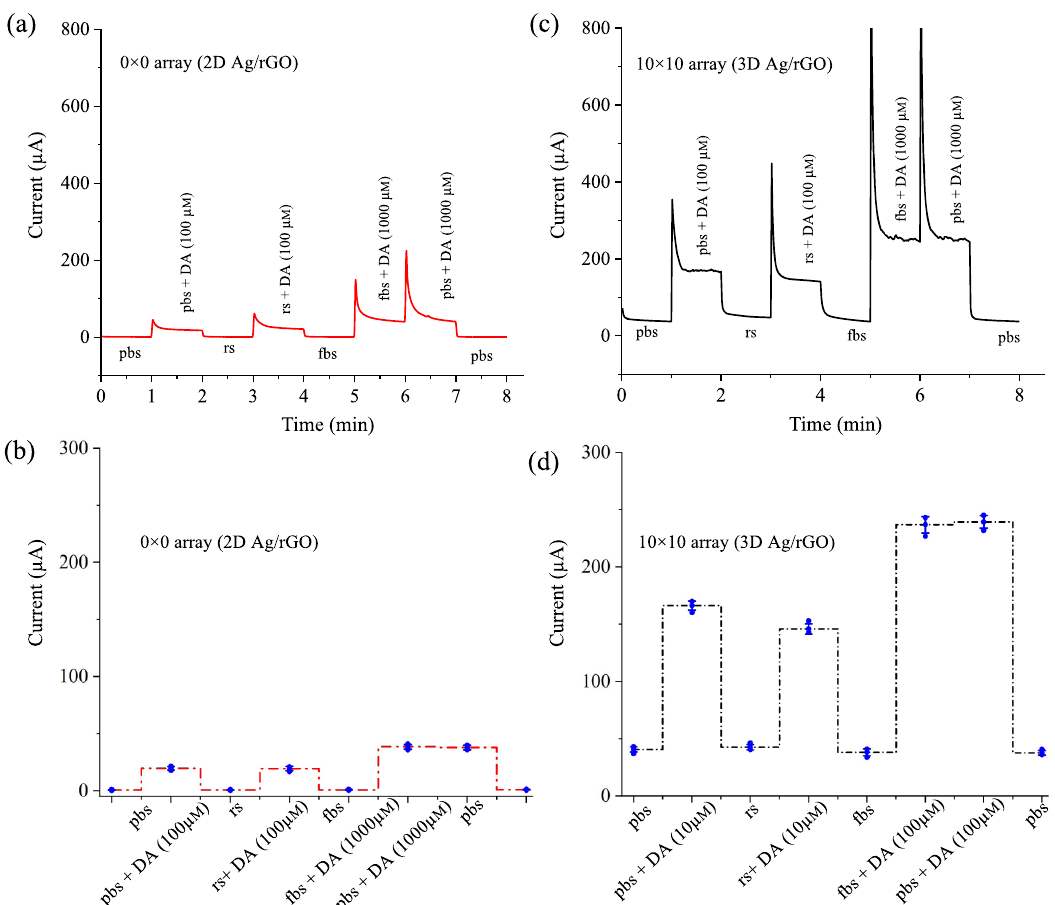
Fig. 5 In vitro dopamine sensing. Use of chronoamperometric method to detect dopamine for ( a ) 2D Ag/rGO (0 × 0 array) and ( c ) 3D Ag/rGO (10 × 10 array) sensors in the presence of pbs, fetal bovine serum (fbs), and rabbit serum (rs) with and without the addition of different concentration of dopamine (10, 100, and 1000 μ M ). Both rs and fbs are diluted 15 times and mixed with dopamine concentration. b , d The chronoamperometric responses of serums with and without dopamine for both the sensors. Error bars in ( b ) and ( d ) are the standard deviation of measurements over at least n = 3 biologically independent experiments. Error bars, mean ± Supplementary Fig. 10 for AS. The chronoamperometric response of the sensor for HP with and without dopamine are shown in Fig. 6a. The sensor signal current with diluted HP without dopamine shows a deviation of ± 4.9 µA (~ ±10%; n = 18) from the mean signal (47.6 µA). Once dopamine is added into the diluted HP, the sensing current is increased signi fi cantly compared to the baseline signal ( p -value < 0.0001, which is